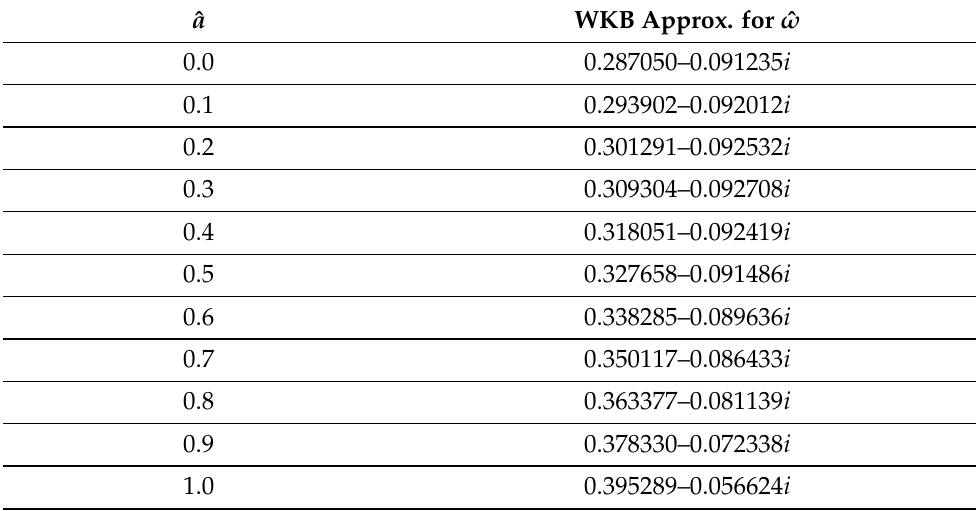
Table 1. Fundamental QNM of the spin one field for (cid:96) = 1, obtained via first-order WKB